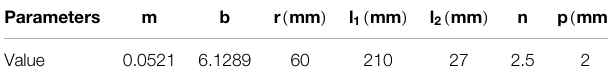
TABLE 2 | System parameter and mechanism size.